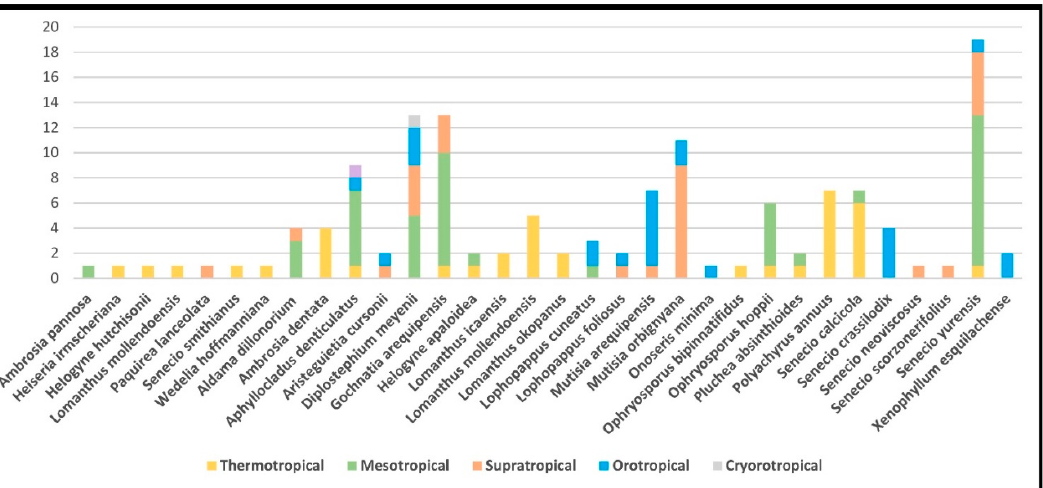
Figure 6. Distribution of the endemisms and semi-endemisms of Asteraceae of the Arequipa Region on the bioclimatic belts. Those on a single bioclimatic belt are bioindicators.